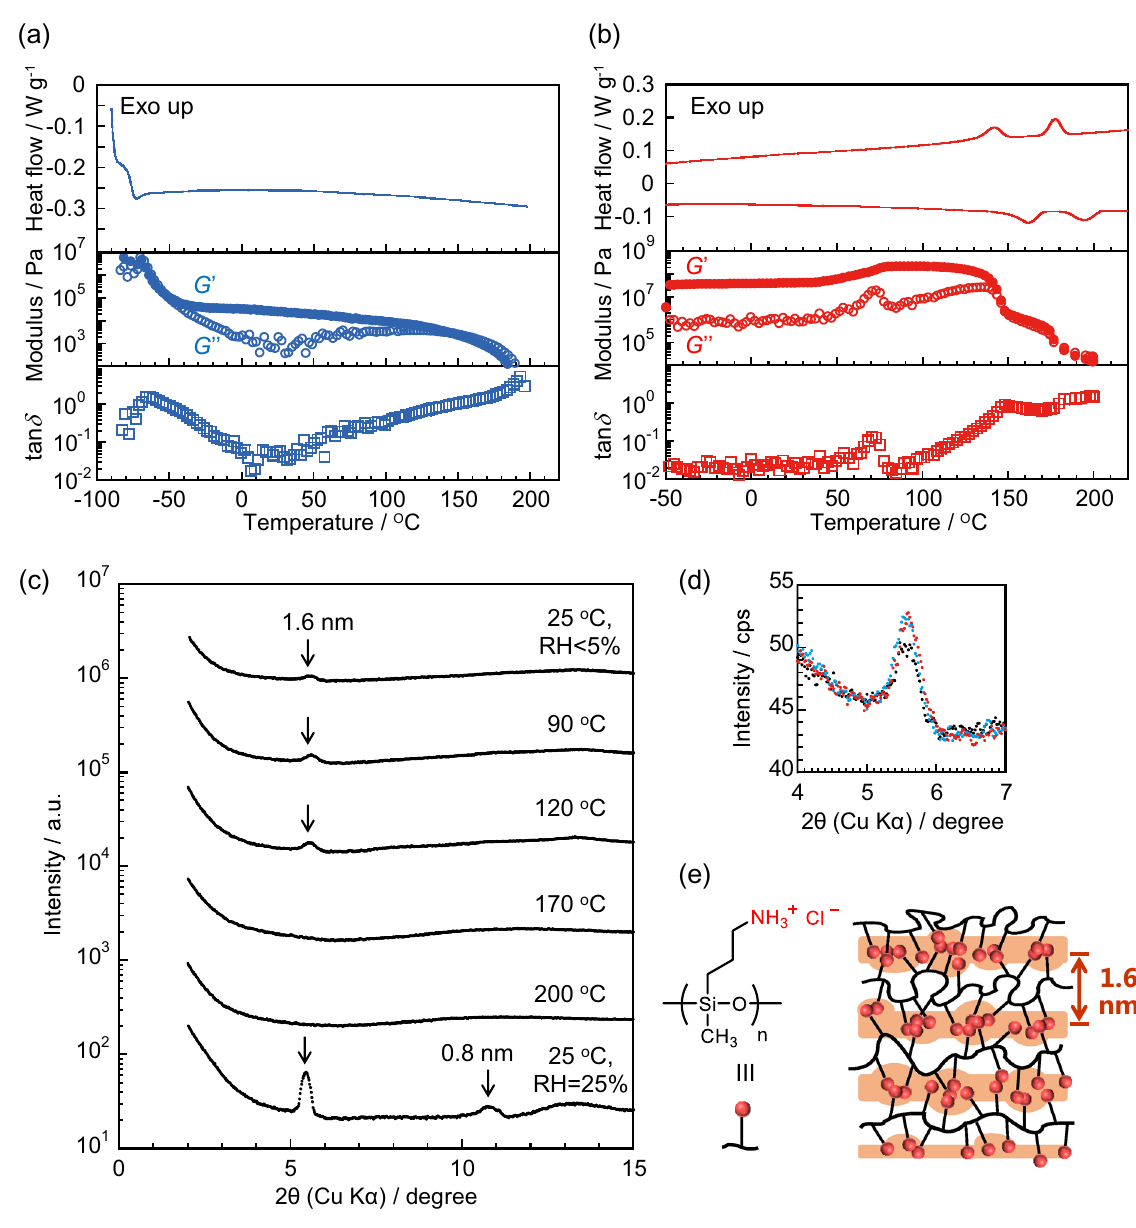
Figure 3. DSC curves and modulus profiles. ( a ) Dry-PSx(NH 2 ) and ( b ) dry-PSx(NH 3+ Cl − ). ( c ) Temperature- and humidity-controlled XRD profiles of PSx(NH 3+ Cl − ). ( d ) Magnified and overlay of the XRD profiles in a; black: 25 °C, RH < 5%, red: 90 °C, light blue: 120 °C. ( e ) Schematic of the plausible lamellar structure model of dry-PSx(NH 3+ Cl −